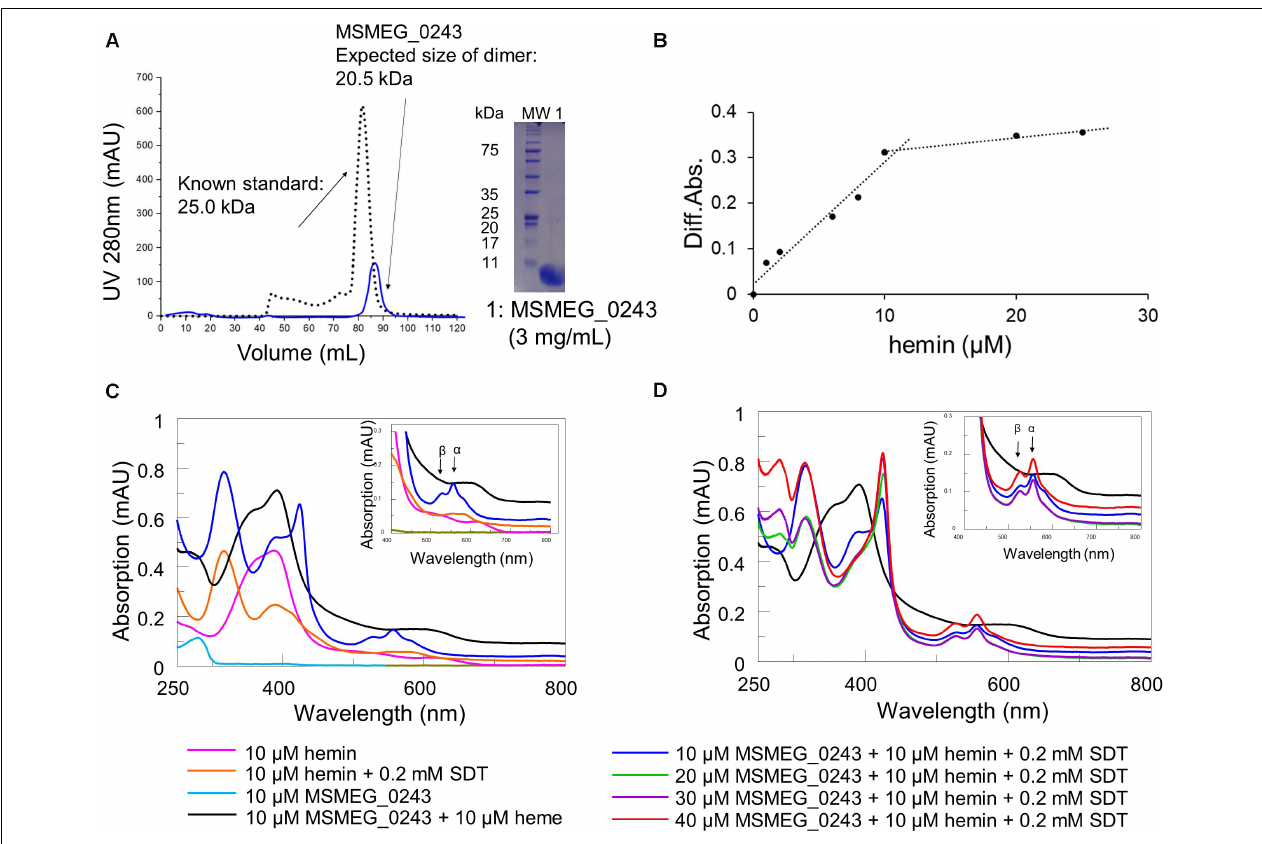
FIGURE 2 | Purification and heme binding of MSMEG_0243. (A) Purification of MSMEG_0243 in its apo form. Size exclusion chromatography was performed after purification of MSMEG_0243 via Strep-tag. The elution profile (blue line) and subsequent SDS-PAGE analysis of the combined elution fractions are shown. Overlay of the chromatogram of MSMEG_0243 (blue line, size of dimer: 20.5 kDa) with a profile from a protein with known size (black dotted line, 25.0 kDa) verified the expected size for a protein dimer. (B) Titration of hemin to apo- MSMEG_0243 (10 µ M) is observed by the spectral change at 420 nm between protein plus hemin and hemin only. The protein saturates at 10 µ M hemin, indicating a 1:1 binding ratio. (C) Absorbance spectrum of apo- MSMEG_0243 (light blue line) and heme-bound MSMEG_0243 (black line) and comparison to hemin only (pink line). Reduction by the addition of 0.2 mM sodium dithionite (dark blue line) shifts the Soret band from 392 to 424 nm. Control conditions are hemin only plus 0.2 mM sodium dithionite (orange line). (D) Increasing concentrations of apo- MSMEG_0243 were added to the reduced heme- MSMEG_0243 complex. Represented by the blue line that shifts to (i) light green (20 µ M), (ii) violet (30 µ M), and (iii) red line (40 µ M). The observed peak increase at 392 nm potentially is a result of ferrous heme dissociating from MSMEG_0243. All spectra were recorded under oxygen free conditions in a hypoxic chamber. The insets show the magnified Q-band region. All experiments were performed at least three times and one representative dataset is shown. SDT: sodium